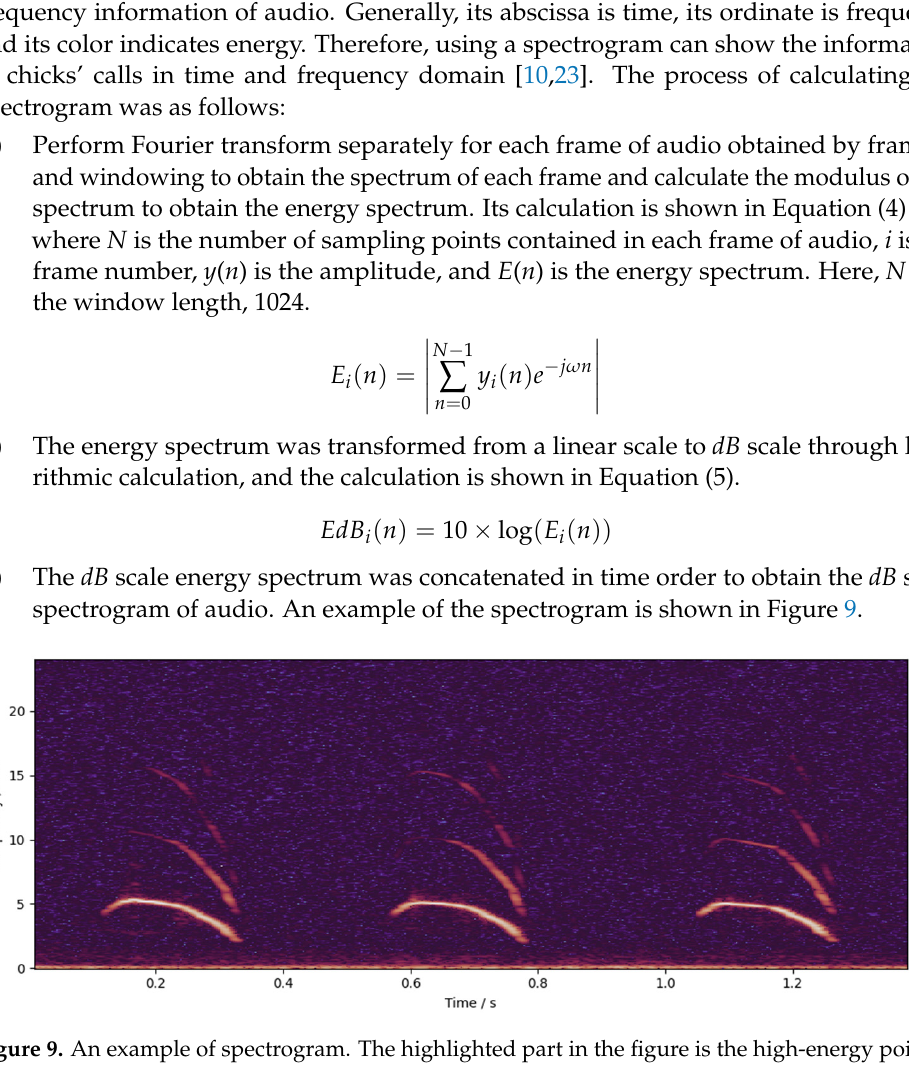
Figure 9. An example of spectrogram. The highlighted part in the figure is the high-energy point of the sound in the time–frequency domain. It can be seen that the pitch frequency of the chicken call is about 5000 Hz, while the frequency of the formant is higher, up to about 16,000